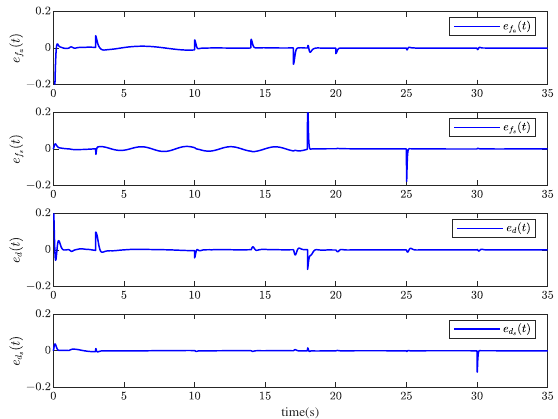
( t ) , and ( t ) , e ( t ) , e f s d a